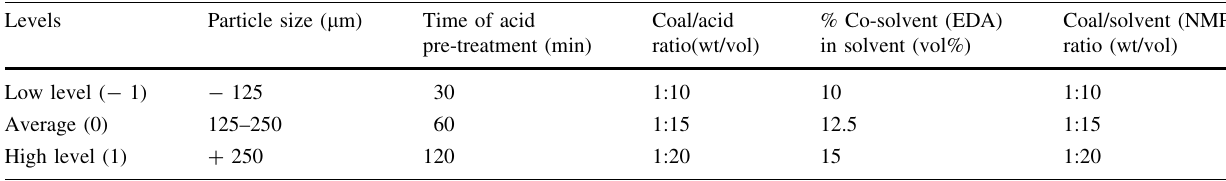
Table 3 Three level factorial design for optimization of five parameters Levels